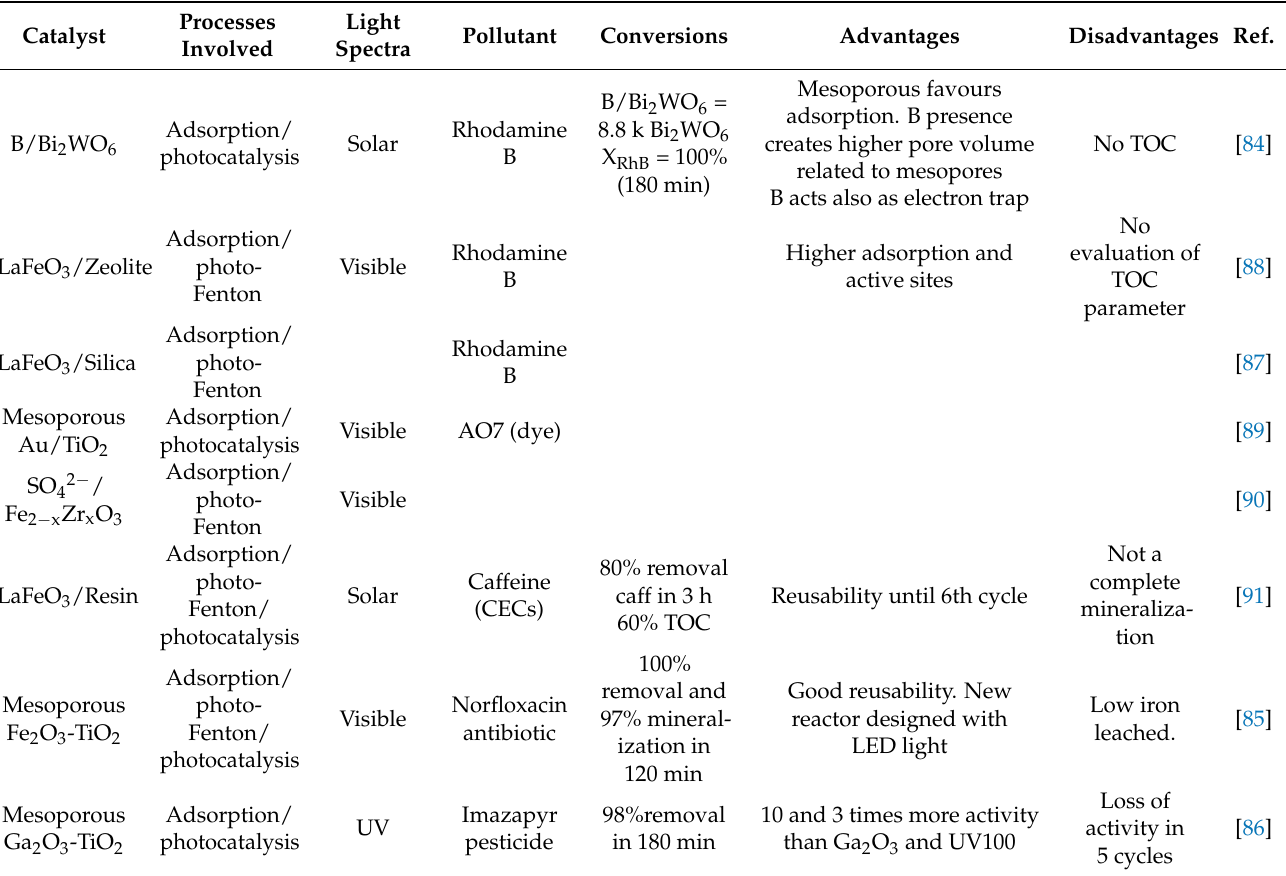
Table 5. Catalyst used for combining adsorption and photo-assisted